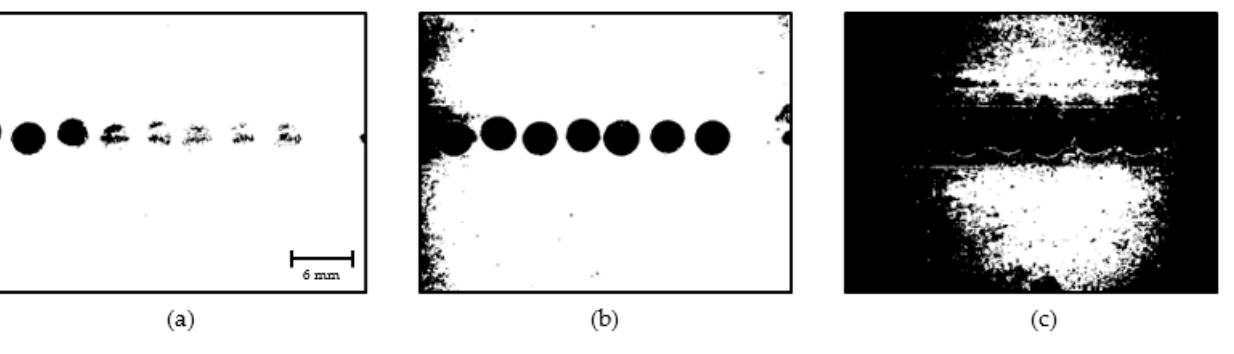
Figure 10. Band filtering: ( a ) Original image; ( b ) Red segment; ( c ) Green segment; ( d ) Blue segment; ( e – h ) Respective histograms.